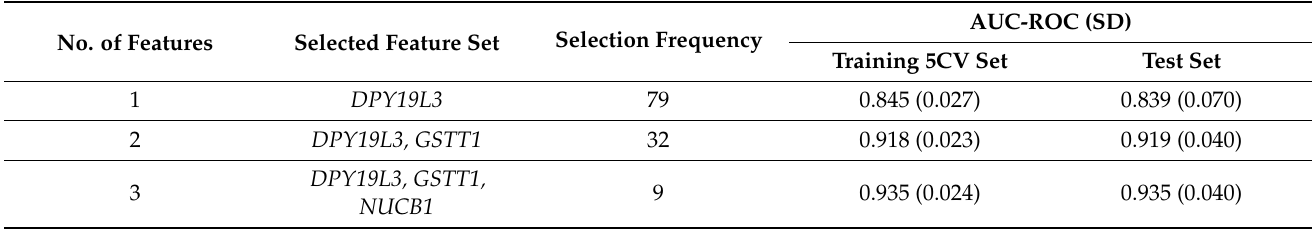
Table 3. The most frequently selected combination of two or three genes for the whole-blood expression imputation model and its performance for classifying NDR vs.